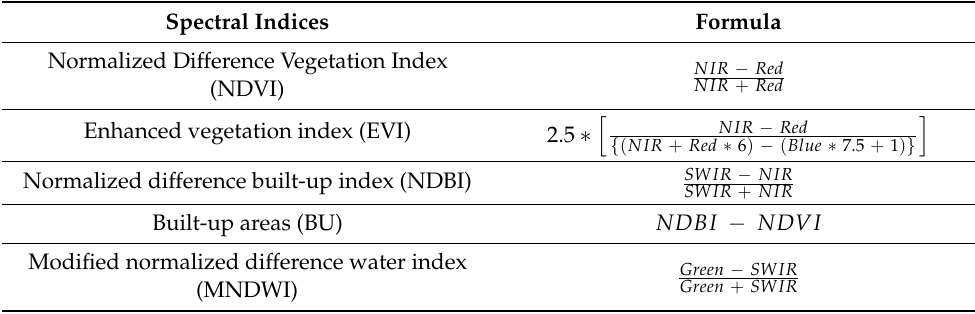
Table 3. Formulae to calculate